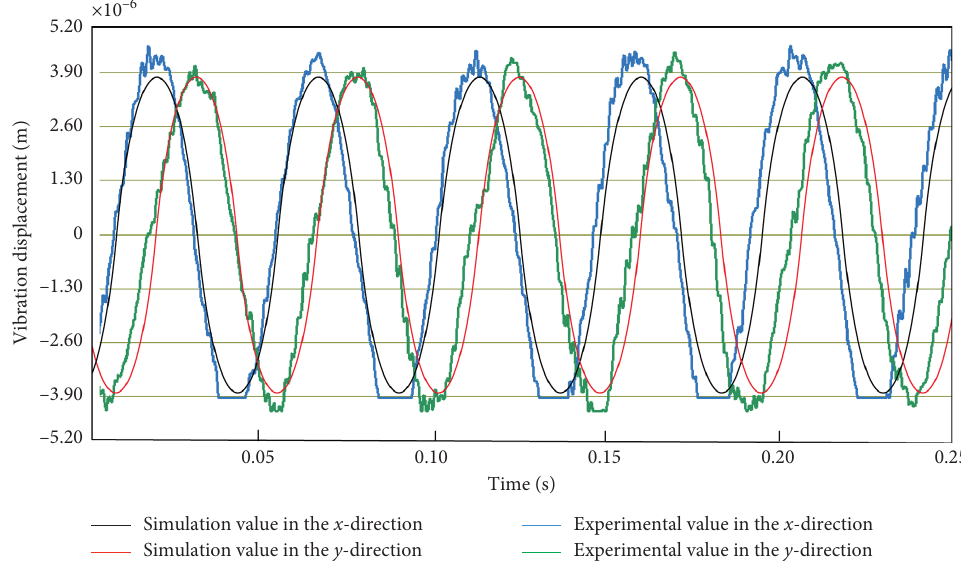
Figure 13: Comparison of experimental values and simulated values of radial vibration displacement at 600 r/min.